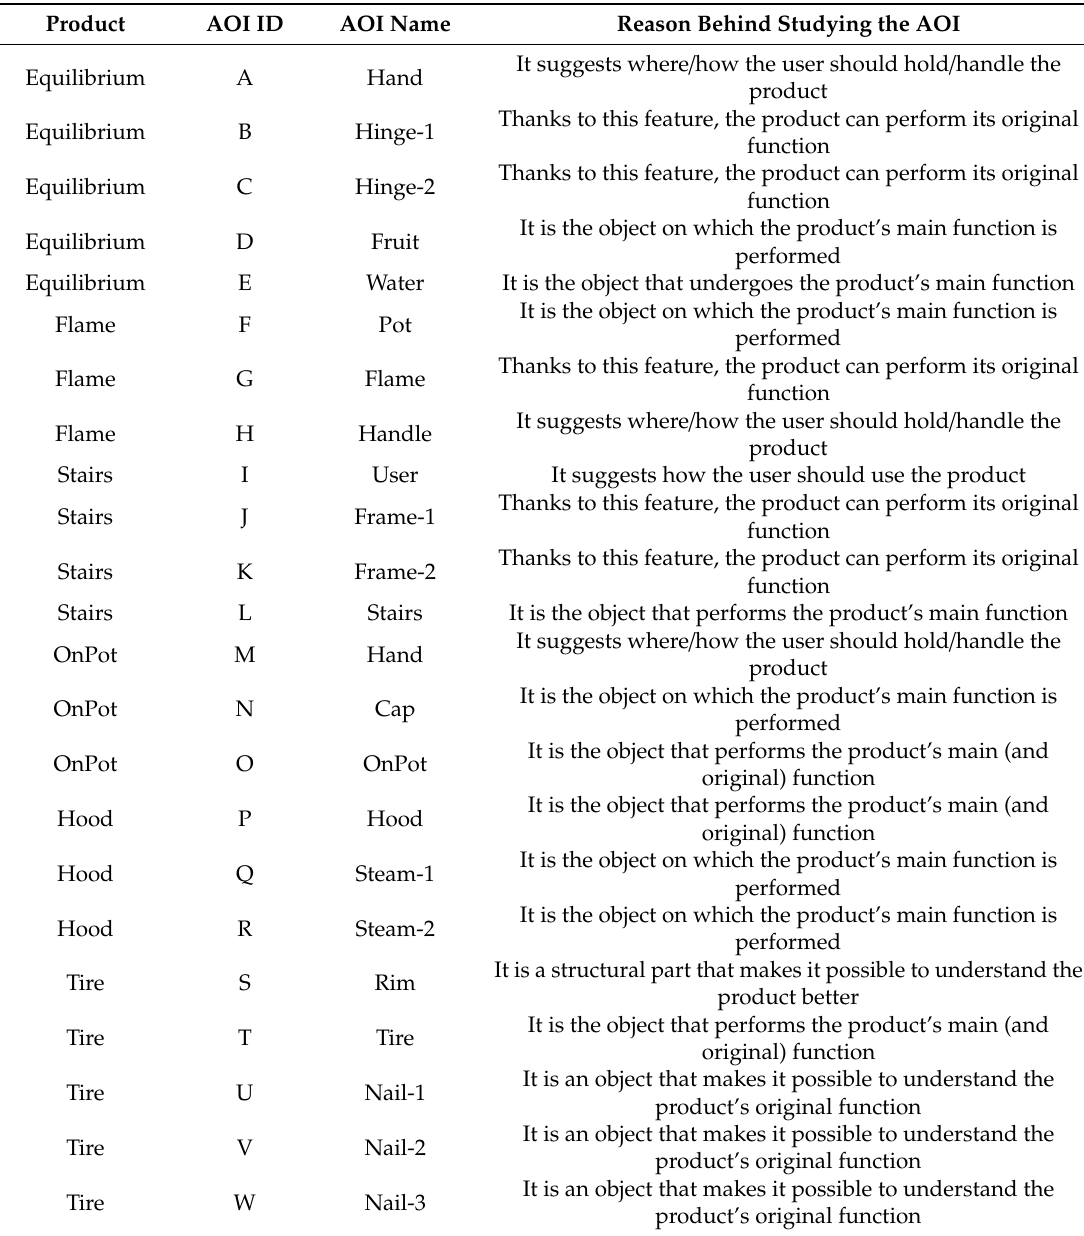
Table 2. AOIs created and coded, and reasons behind their presence. IDs correspond to those of Figure